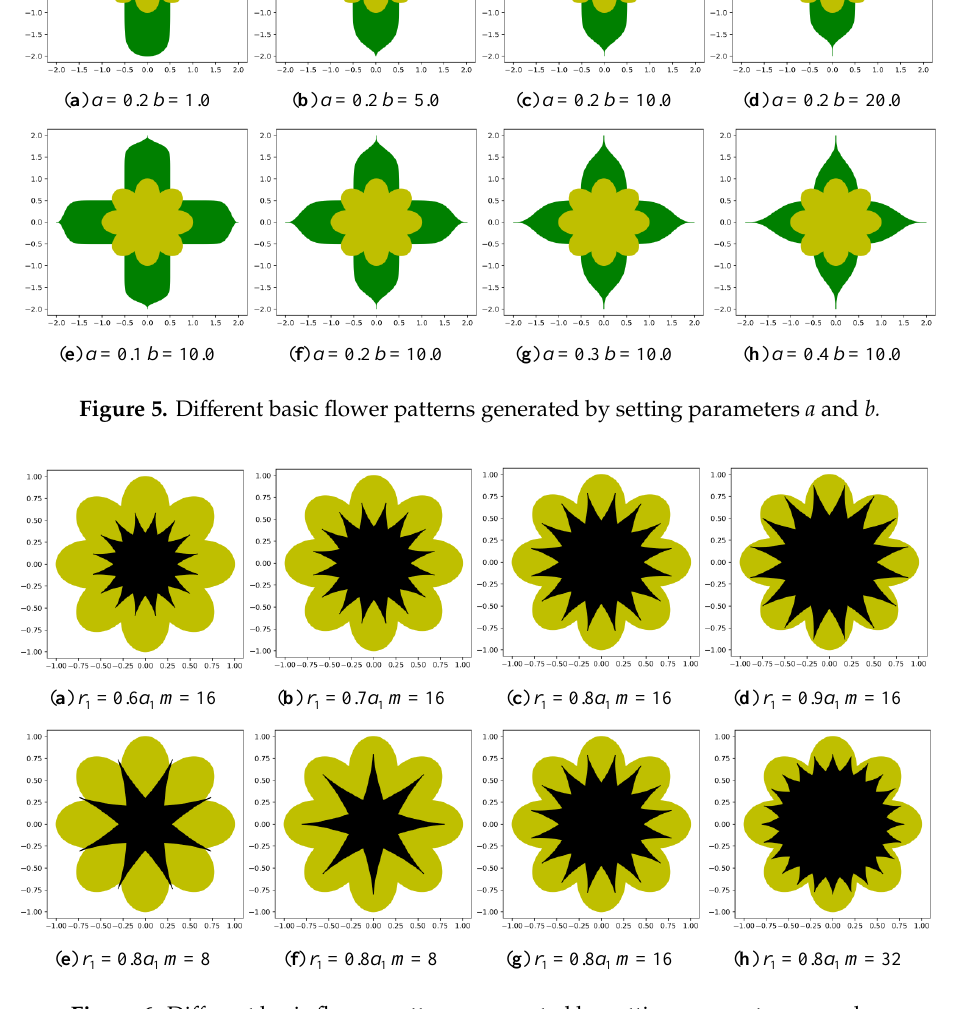
Figure 6. Different basic flower patterns generated by setting parameters a 1 and m.